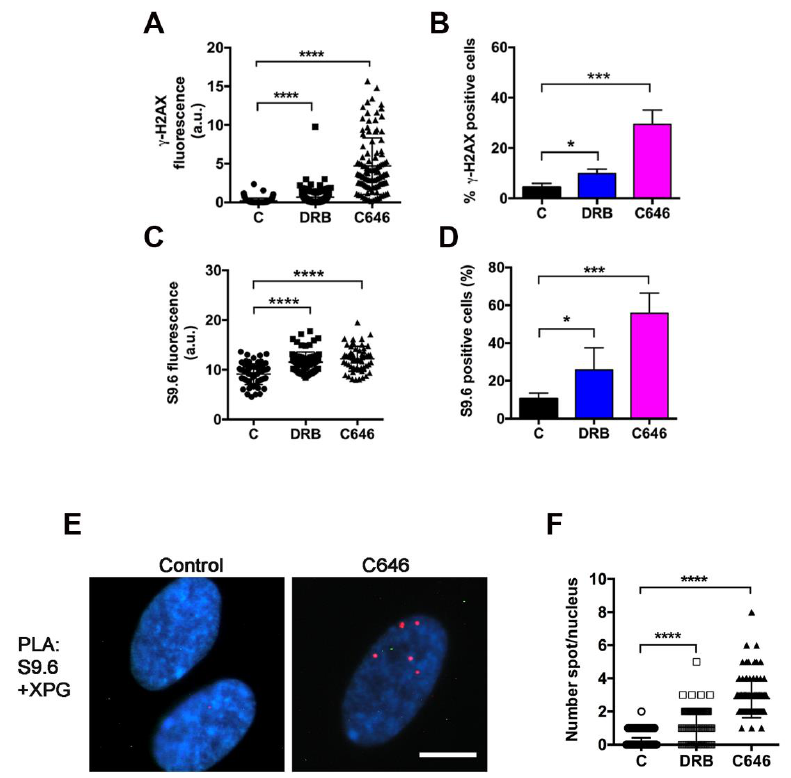
Figure 5. Relocalization of XPG induced by transcription inhibition occurs in concomitance with the phosphorylation of histone H2AX and R-loop formation. ( A ) Quantitative analysis of histone γ-H2AX immunofluorescence staining in LF-1 fibroblasts treated with DRB or C646. At least 50 cells (from 2–3 independent experiments) were measured. Error bars with SEM shown. (**** p < 0.0001). ( B ) Quantitative analysis of positivity to immunofluorescence staining of histone γ-H2AX, in LF-1 fibroblasts treated with indicated inhibitors of transcription. Mean values ± S.D. of three experiments shown. (* p < 0.05; *** p < 0.001). ( C ) Quantitative analysis of S9.6 immunofluorescence staining in LF-1 fibroblasts treated with indicated inhibitors. At least 50 cells (from 2–3 independent experiments) measured. Error bars with SEM shown. (**** p < 0.0001). ( D ) Quantitative analysis of positivity to immunofluorescence staining of RNA/DNA hybrids with S9.6 antibody, in LF-1 fibroblasts treated with indicated inhibitors. Mean values ± S.D. of three experiments shown. (* p < 0.05; *** p <0.001). ( E ) PLA assay performed in LF-1 fibroblasts after treatment with C646. Red spots represent the positivity of the reaction. Scale bar: 10 μm. ( F ) Quantitative analysis of the number of PLA spots/nucleus in (C) untreated, DRB-, or C646-treated LF-1 fibroblasts. Scatter plot shows pooled data from two independent experiments. Number of spots in at least 50 cells/experiment was counted. (**** p <